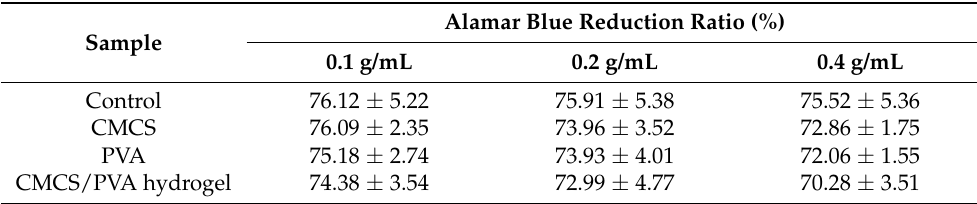
Table 1. Effect of hydrogel leaching solution concentration on L929 cell activity.